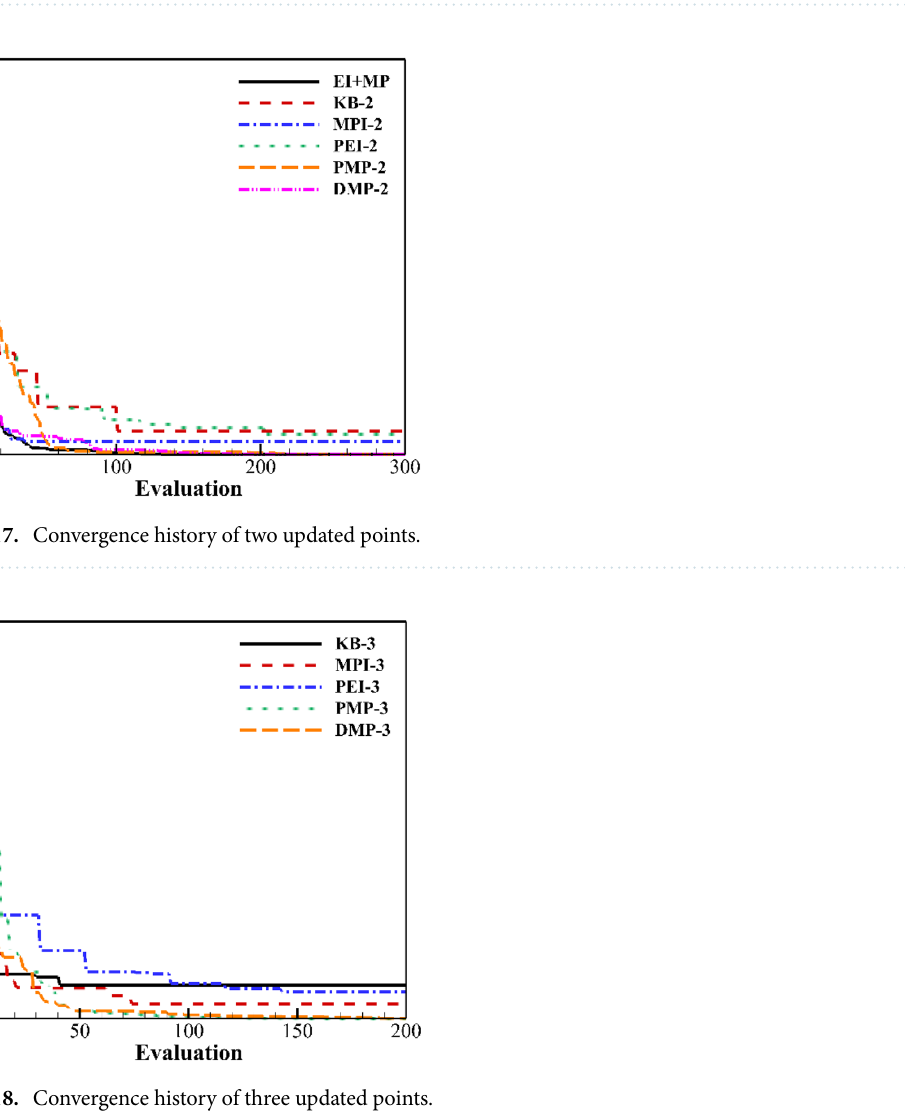
Figure 16. Convergence history of single updated point.